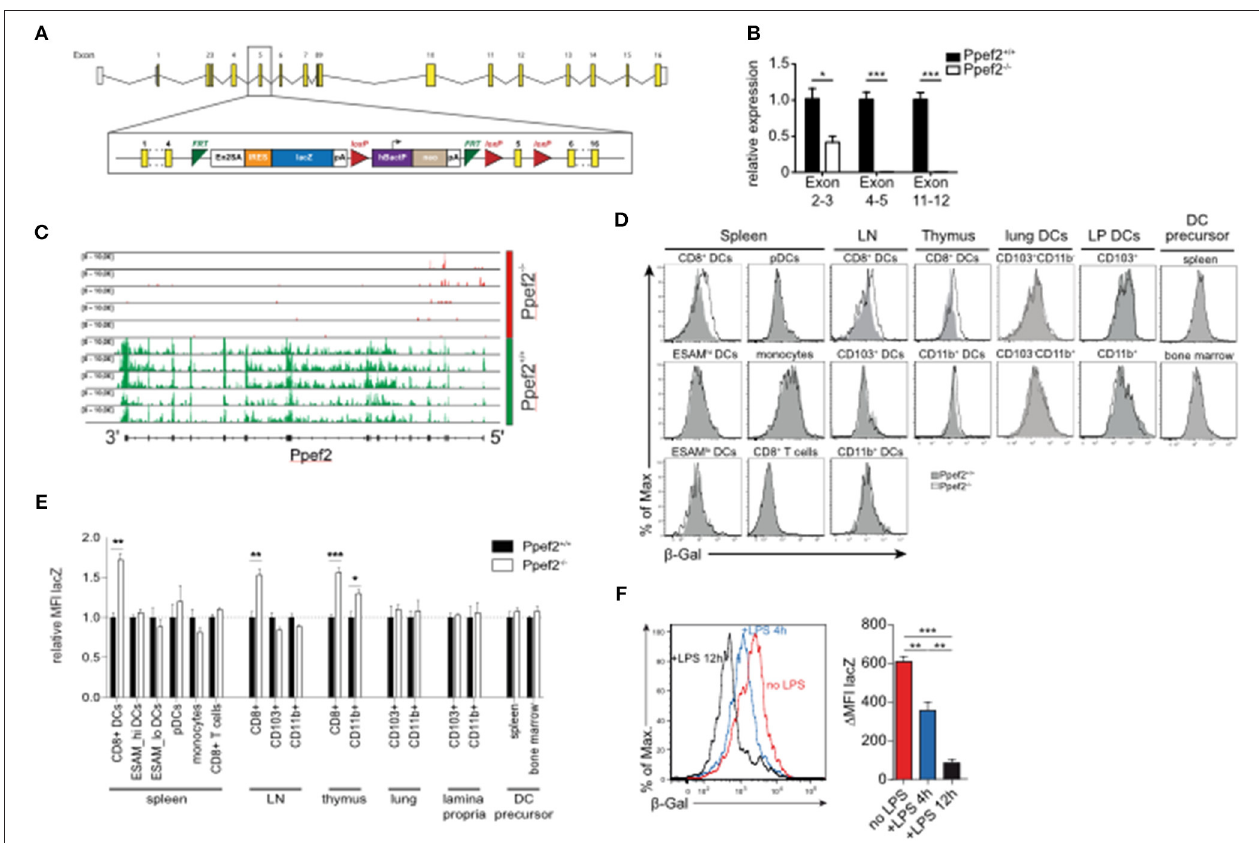
FIGURE 2 | Ppef2-knockout strategy and LacZ-Reporter. (A) The Ppef2 locus with the knockout-first construct containing the gene trap between exon 4 and 5, as well as the floxed exon 5. (B) Ppef2 expression analysis of CD11c enriched splenocytes in Ppef2 + / + and Ppef2 − / − mice by quantitative real-time PCR. Three sets of intron-spanning primer pairs were used to amplify fragments from exons 2 to 3, 4 to 5, and 11 to 12. The 1 Ct method was used to calculate the fold expression compared to Ppef2 + / + control samples. Data was normalized to HPRT ( n = 3 mice). (C) Genomic distribution of reads across the Ppef2 gene locus in Ppef2 + / + and Ppef2 − / − CD8 + DCs. (D) Measurement of ß-Gal activity by flow cytometry in different cell types of the spleen, lymph node, thymus and bone marrow. Shown are representative FACS-plots of three experiments with similar outcome. (E) The mean fluorescence intensity (MFI) was calculated from one representative experiment out of two with identical outcome ( n = 4). (F) Flow cytometric measurement of ß-Gal activity in splenic CD8 + DCs. Ppef2 lacZ / lacZ reporter mice (red, uninjected) were injected intravenously with LPS either 4h (blue) or 12h (black) before analysis. Shown are FACS-plots and statistics, where the ß-Gal signal of reporter mice was subtracted from the ß-Gal background signal of control mice ( n = 18 mice). Statistical analyses were performed by using Student’s t -test, with * p < 0.05; ** p < 0.01; *** p <